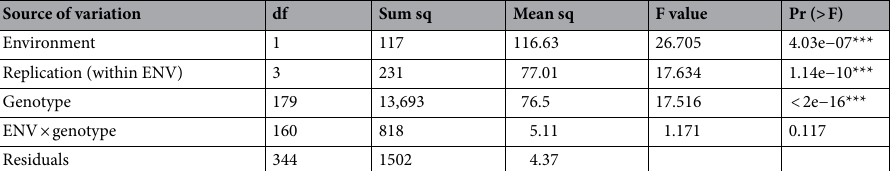
Table 1. Analysis of variance (ANOVA), for number of cysts of H. avenae in 180 wheat accessions. Significant at ***0.001. df degree of freedom, Sum sq sum of